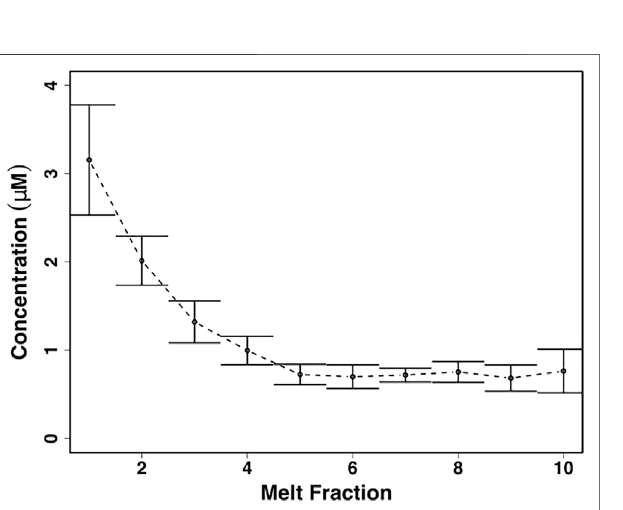
Frontiers in Earth Science |